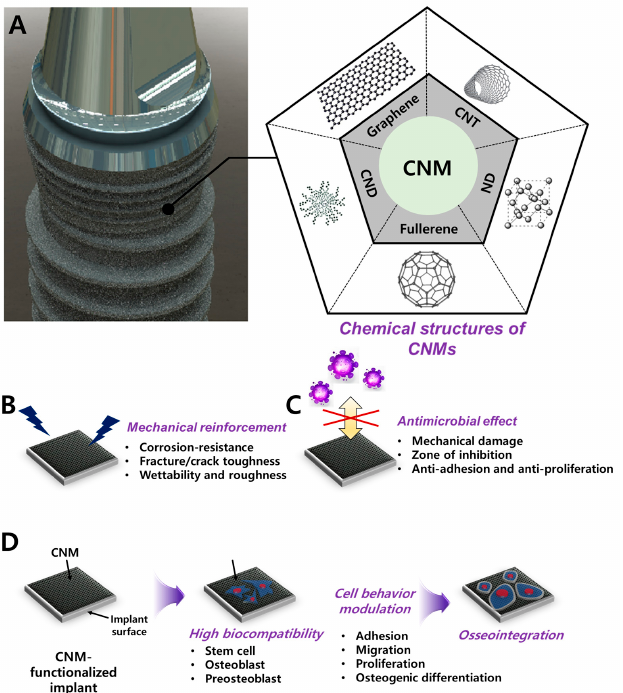
Figure 1. Schematic diagram of CNM functionalization on dental implants for dental tissue engineer- ing and regeneration. ( A ) Graphic of CNM-functionalized implants and chemical composition of the CNM family, including graphene, CNT, CND, fullerene, and ND. Enhanced properties were demon- strated, such as ( B ) mechanical reinforcement, ( C ) an antimicrobial effect, and ( D )